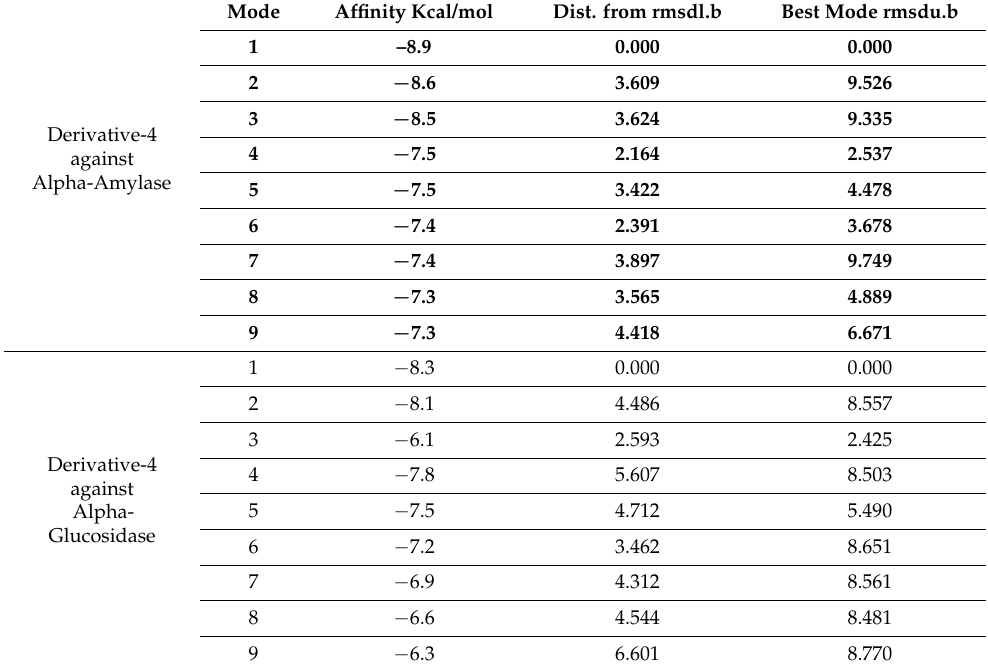
Table 2. Represent the binding affinities and best mode RMSD of analog 4 against Alpha-amylase and Alpha-glucosidase.